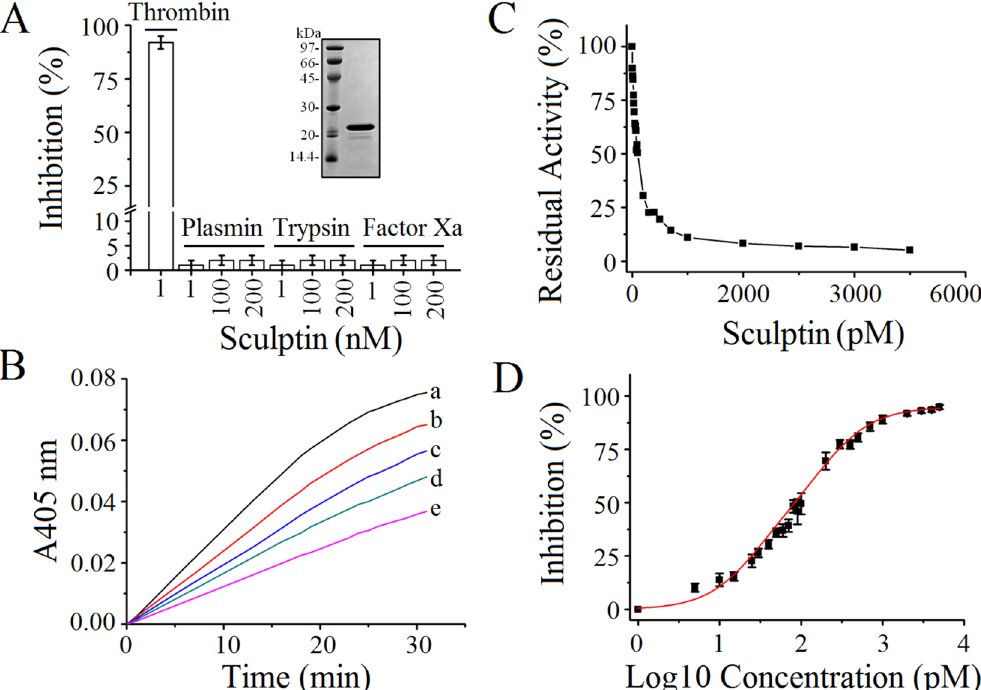
Figure 2. Sculptin specificity for thrombin and its dose-dependency and IC 50 value for thrombin inhibition. ( A ) The inhibition of serine proteases by sculptin. Serine protease (100 pM; thrombin, plasmin, trypsin or factor Xa) was incubated with sculptin (1, 100 and 200 nM) in 50 mM phosphate buffer containing 150 mM NaCl and 0.1% PEG 6000, pH 7.4 for 6 h at 37 °C. After addition of the corresponding chromogenic substrate to the reaction mixture, its hydrolysis was monitored at 405 nm. For factor Xa activity, the buffer contained 50 µ M phosphatidylserine and phosphatidylcholine. The inset in ( A ) shows the SDSPAGE of purified recombinant sculptin, which was used in the experiments. ( B ) Typical curves for hydrolysis of S-2238 chromogenic substrate (15 µ M) by 0.1 nM thrombin in the absence (trace a) or presence of sculptin (trace b, 15 pM; trace c, 30 pM; trace d, 60 pM and trace e, 100 pM) in 50 mM phosphate buffer containing 150 mM NaCl and 0.1% PEG 6000, pH 7.4 at 37 °C. ( C ) Residual activity of thrombin in presence of increasing concentration of sculptin. ( D ) Dose- response curve for thrombin inhibition by sculptin. The percentage of thrombin inhibition was plotted versus the log of sculptin concentration. The experimental condition of ( C ) and ( D ) is the same as in ( B ). The results shown in ( C ) and ( D ) correspond to the mean ± standard deviation values acquired in three independent